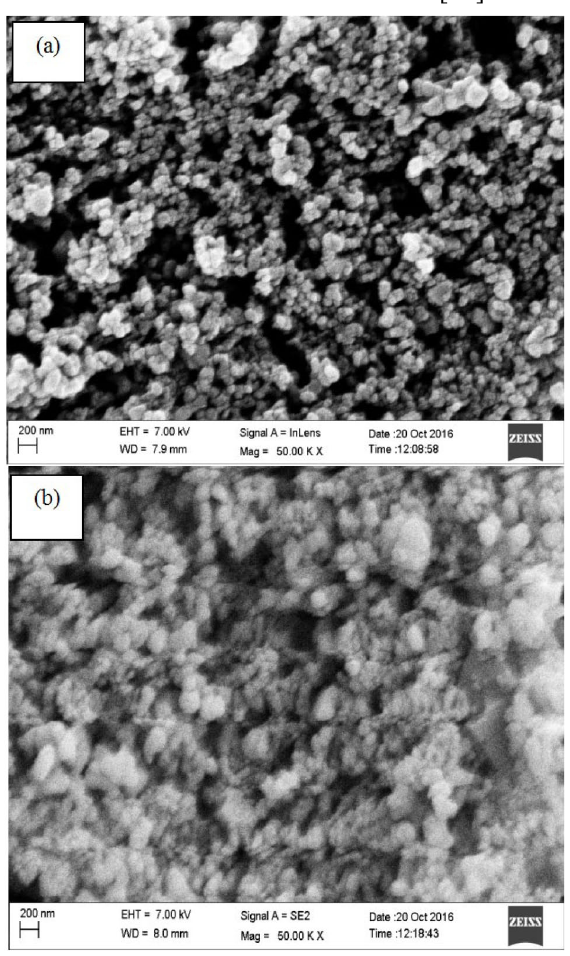
Fig. 2 Field-emission scanning electron microscopic images of (a) 393 K-annealed and (b) un-annealed films under 50 K